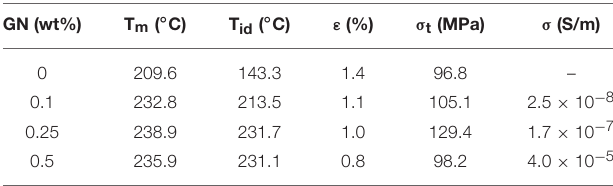
TABLE 2 | Thermal parameters, tensile strain at break ( ε ), tensile strength ( σ t ), and electrical conductivity ( σ ) of CNW films and CNW/GN composite